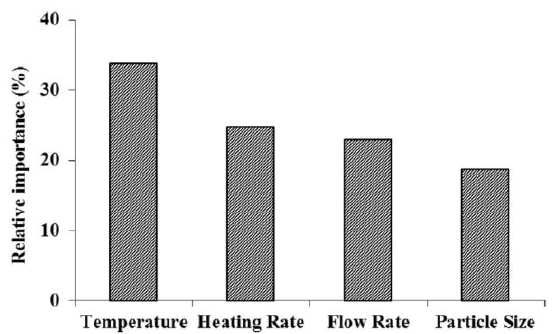
Figure 4. The example of relative importance analysis for input descriptors of trained neural network model [63]. Reprinted by permission from Springer Nature.